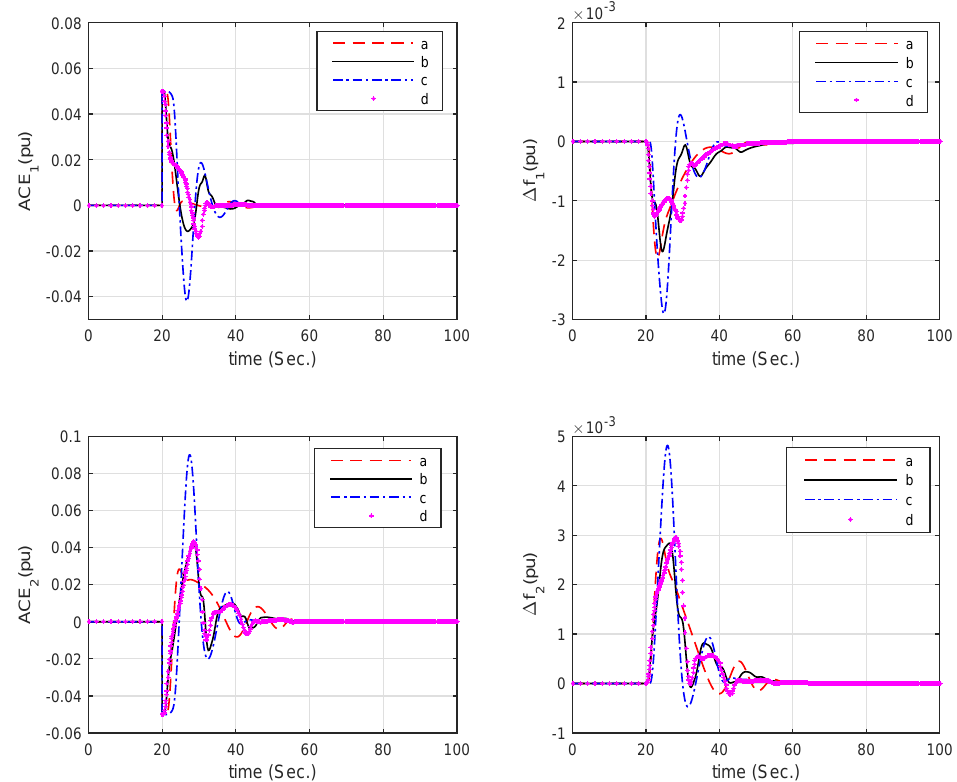
Figure 7. Frequency deviation and control error responses of two-area deregulated LFC scheme with K P = 0.05, K I = 0.4 and time-varying